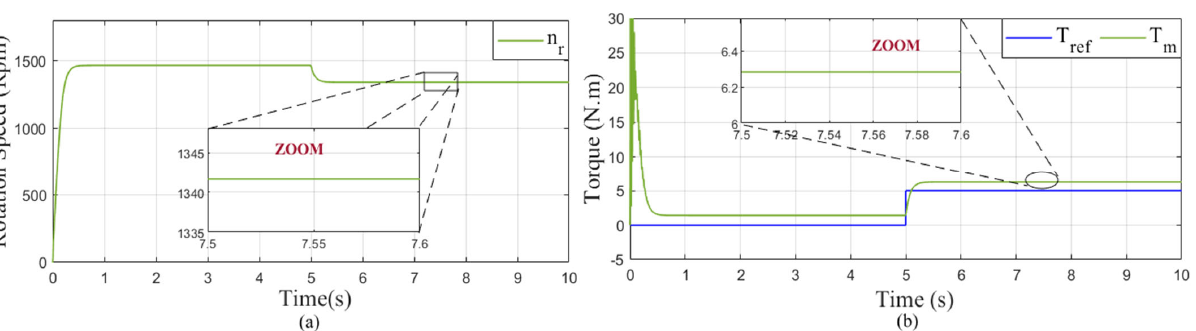
Figure 15. Performance with IR bearing defect of IM without control: ( a ) rotation speed and ( b ) motor torque. Figure 16. Performance with OR bearing defect of IM without control: ( a ) rotation speed and ( b ) motor torque. Figure 17. Performance with Ball bearing defect of IM without control: ( a ) rotation speed and ( b ) motor torque.